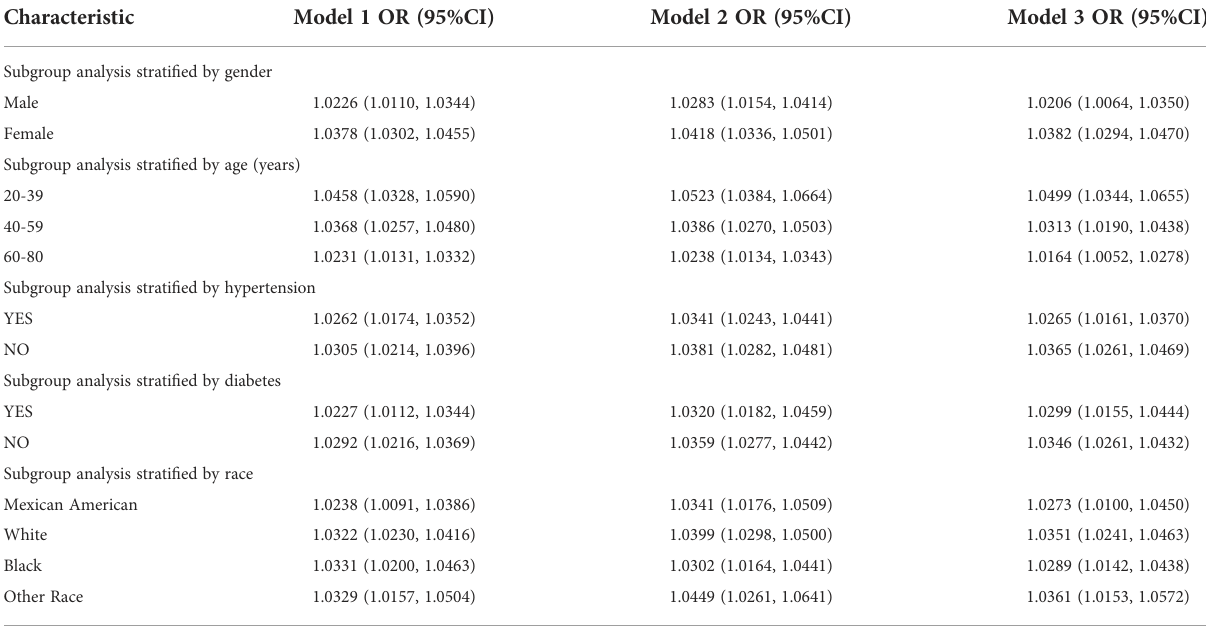
TABLE 3 Subgroup analysis between METS-IR index with gallbladder stone prevalence.